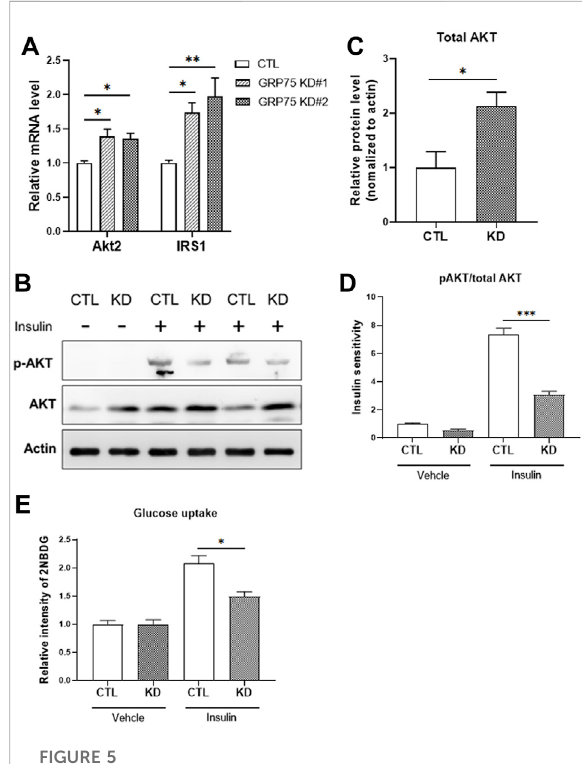
FIGURE 5 Insulin insensitivity of differentiated 3T3-L1 adipocytes with GRP75 knockdown. (A) The mRNA levels of genes involved in insulin signaling (Akt2 and Irs1) were determined in 3T3-L1 preadipocytes with CTL KD, GRP75 KD#1 and GRP75 KD#2 after differentiation. N = 6 in each group. (B – D)